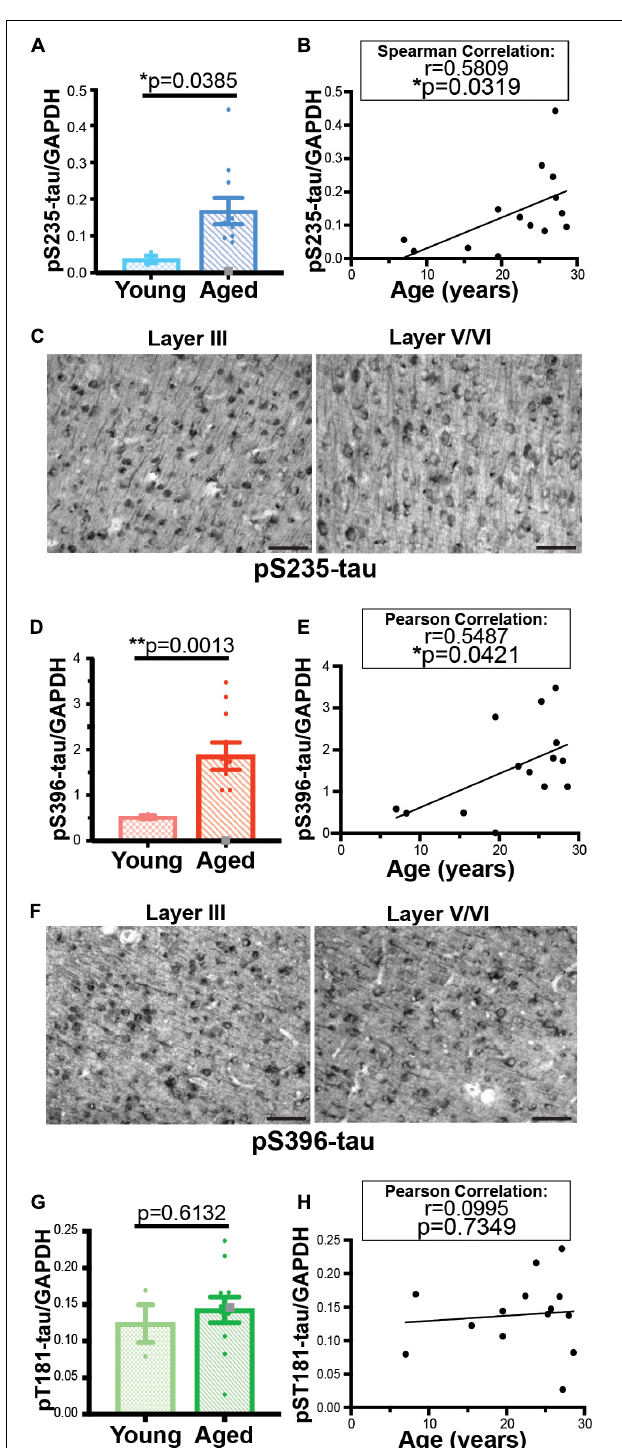
FIGURE 3 | Age-related changes in monkey S235 and S396 validate mass spectrometry results. The 19.5-year-old animal denoted as “low” in the proteomics study and western blots is indicated by a gray square in the graphs. (A) Bar graph summarizing a means comparison of pS235-tau between young (light blue, N = 3) and aged (dark blue, N = 11) macaques.